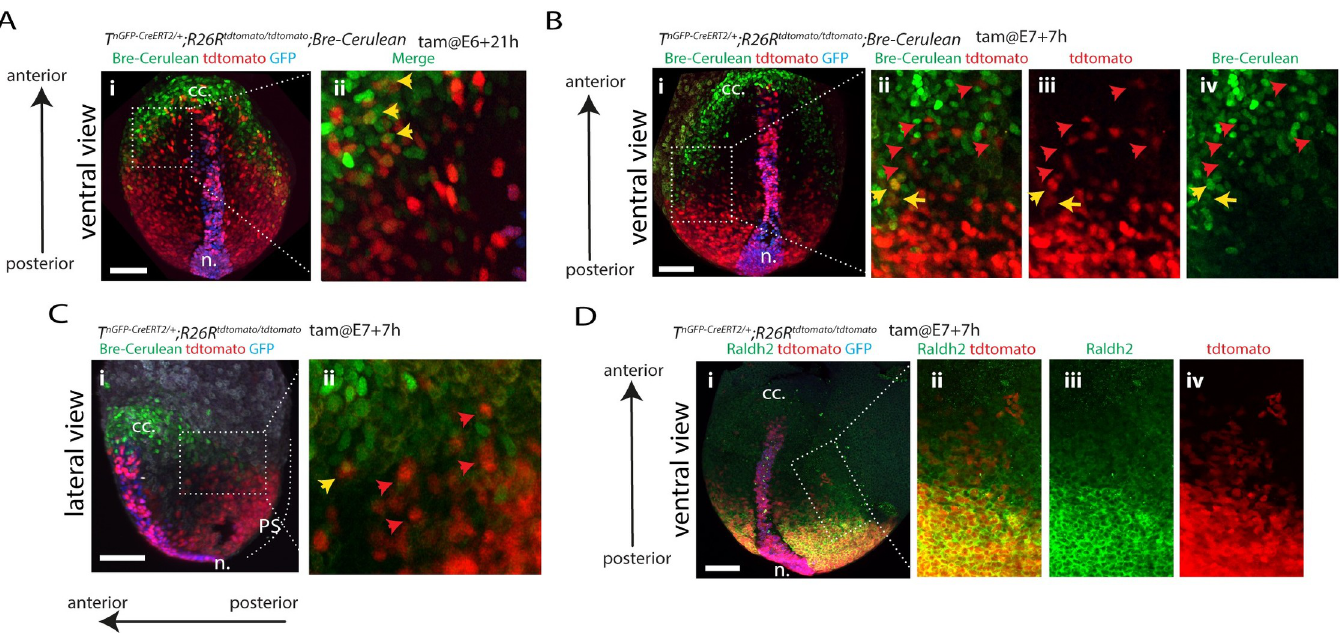
Fig 7. Ventricular, outflow tract, and atrial progenitors are located in distinct regions of the mesoderm. (A, B) tdTomato localisation in T nGPF-CreERT2/+ ; R26R tdTomato/ tdTomato , Bre-Cerulean (BMP reporter) embryos at the EHF stage and following tamoxifen administration at E6+21h (A) and at E7+7h (B, C). Insets Aii, Bii–Biv, and Ci show magnified views of Ai, Bi, and Ci, respectively. Yellow arrows in Ai, Bii–Biv, and Cii point to double tdTomato/Bre-cerulean-positive cells and red arrows in Bii–Biv and Cii to tdTomato+ bre-cerulean − cells. ( D ) tdTomato localisation in T nGPF-CreERT2/+ ; R26R tdTomato/tdTomato embryos at the EHF stage, following tamoxifen administration at E7+7h and immunostained for Raldh2. Insets in ii–iv show magnified view of i. Images are z-maximum projection of 37 sections acquired every 5 μ m and covering 185 μ m. Interval between frames: 6 mn and 30 s. cc, cardiac crescent; EHF, early head fold; ml, midline; n, node; PS, primitive streak. Scale bar: 100 μ